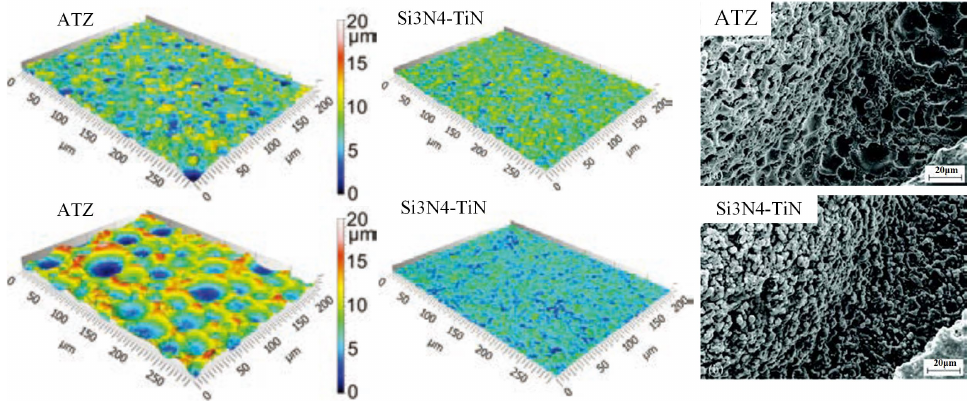
Figure 7. Surface quality analysis and electron microscopy of ATZ and Si 3 N 4 –TiN before and after machining. Reprinted/adapted with permission from Ref. [140]. Copyright 2016, Elsevier. machining. Reprinted/adapted with permission from Ref. [140]. Copyright 2016,